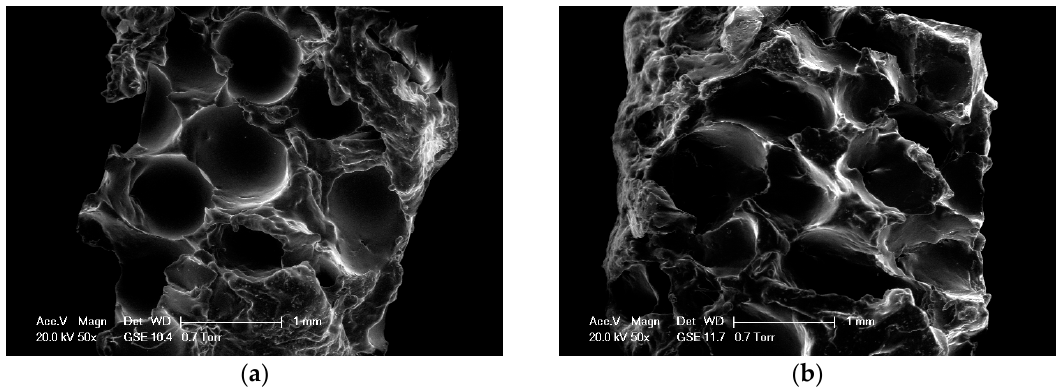
Figure 4. Apparent morphologies of two kinds of asphalts (R and T) under combination D: ( a ) Asphalt R; and ( b ) Asphalt T.